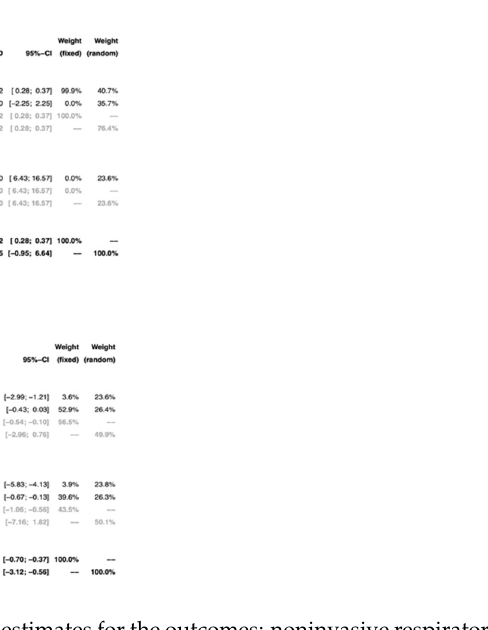
Figure 4. Forest plots depicting the effect estimates for the outcomes: noninvasive respiratory sup- port (NRS) duration and oropharyngeal pressure transmission.